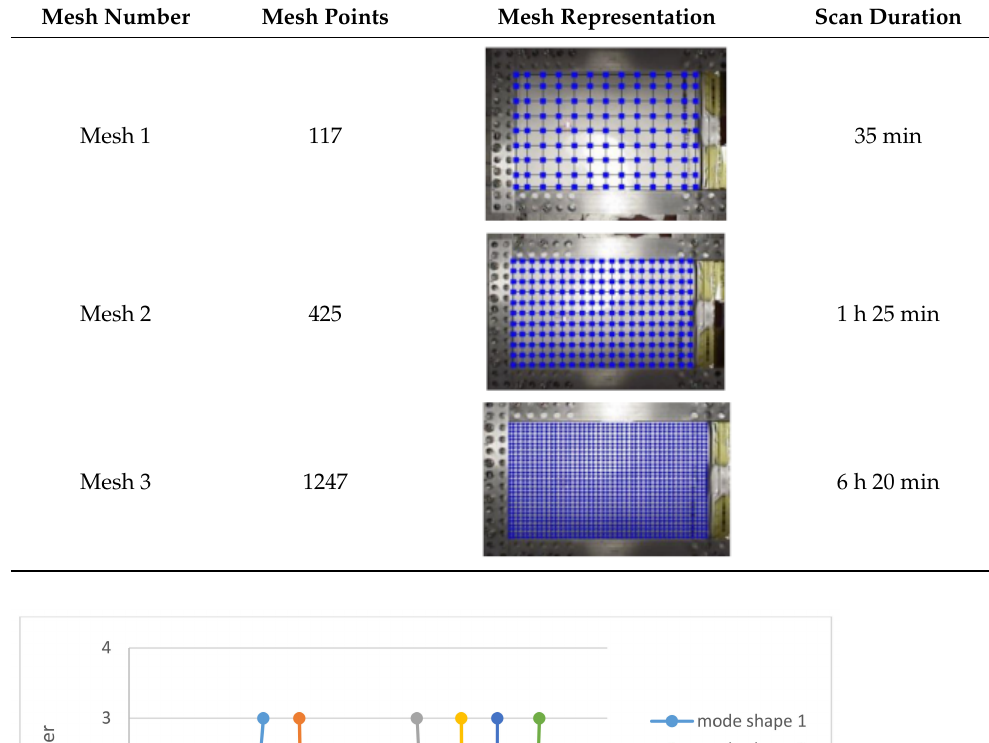
Figure 4. Battery Boundary conditions ( a ) Boundary condition 1, which is the three-side clamped, and ( b ) Boundary condition 2, which is the two-side clamped. Table 3. Mesh representation for the mesh size independency analysis.